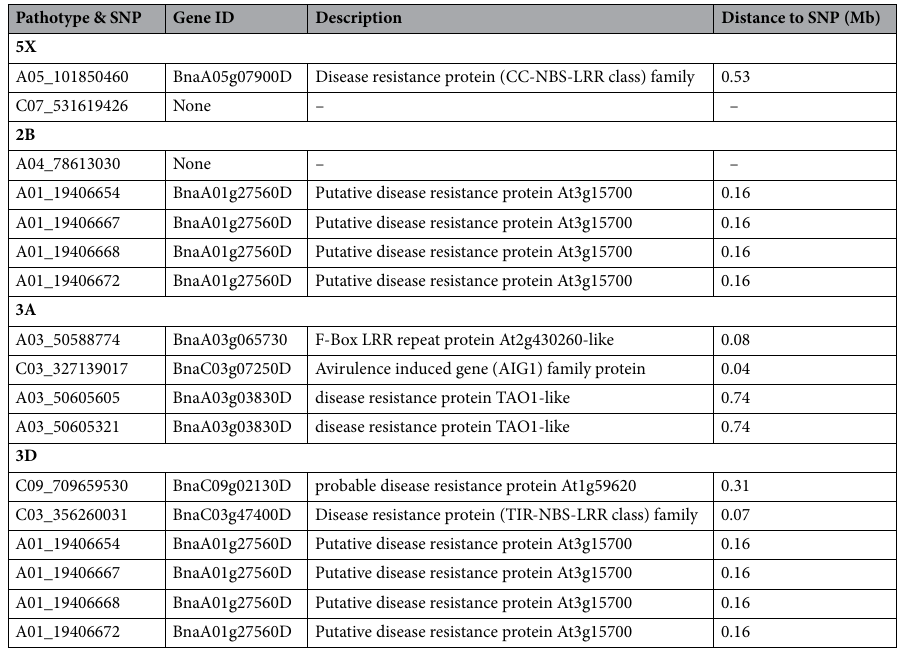
Table 4. Disease resistance genes located within candidate gene region (Mb) of SNP